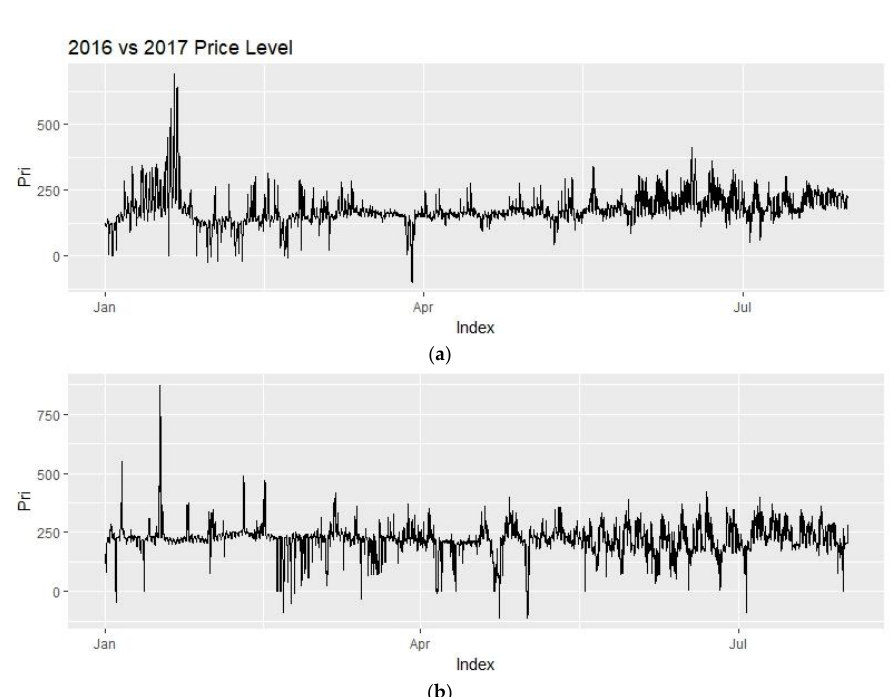
Figure 15. Price comparison: ( a ) 2016 ( b ) 2017.